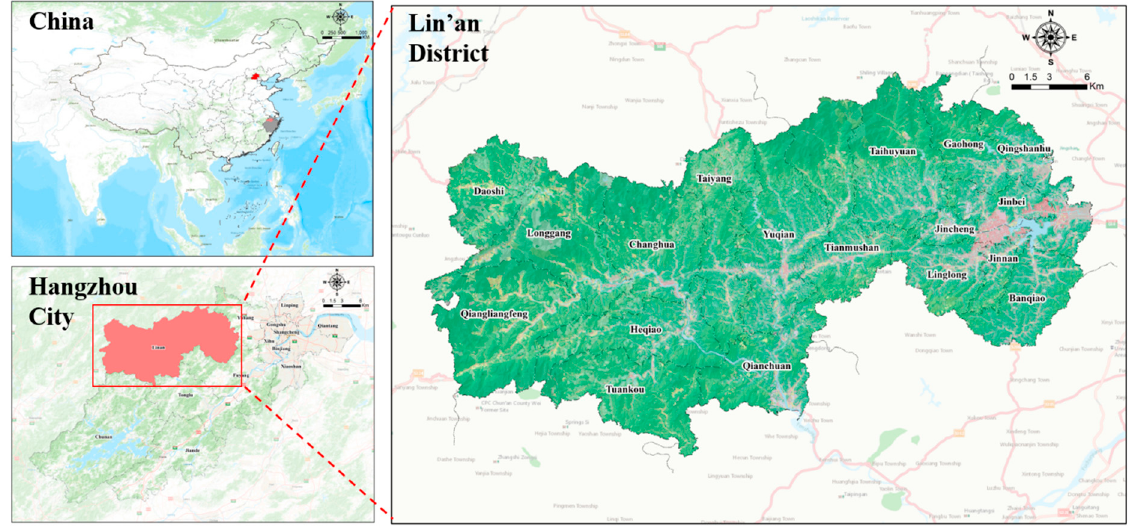
Figure 1. Geographic location of Lin’an District.